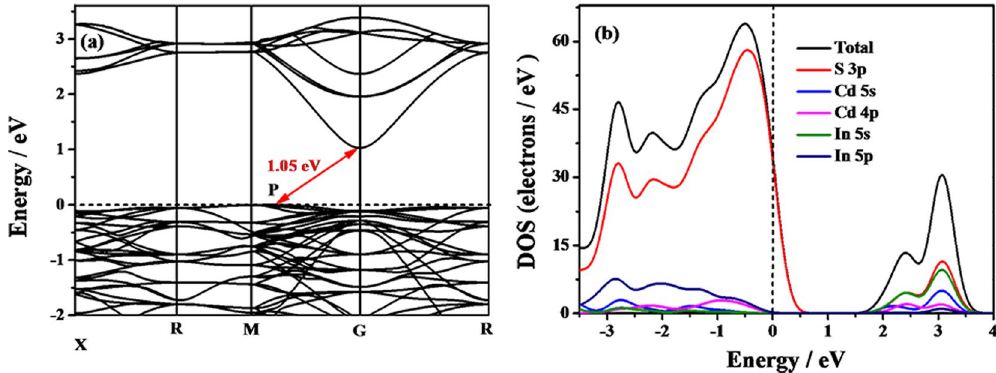
Figure 2. The band structure ( a ) and DOS ( b ) of CdIn 2 S 4